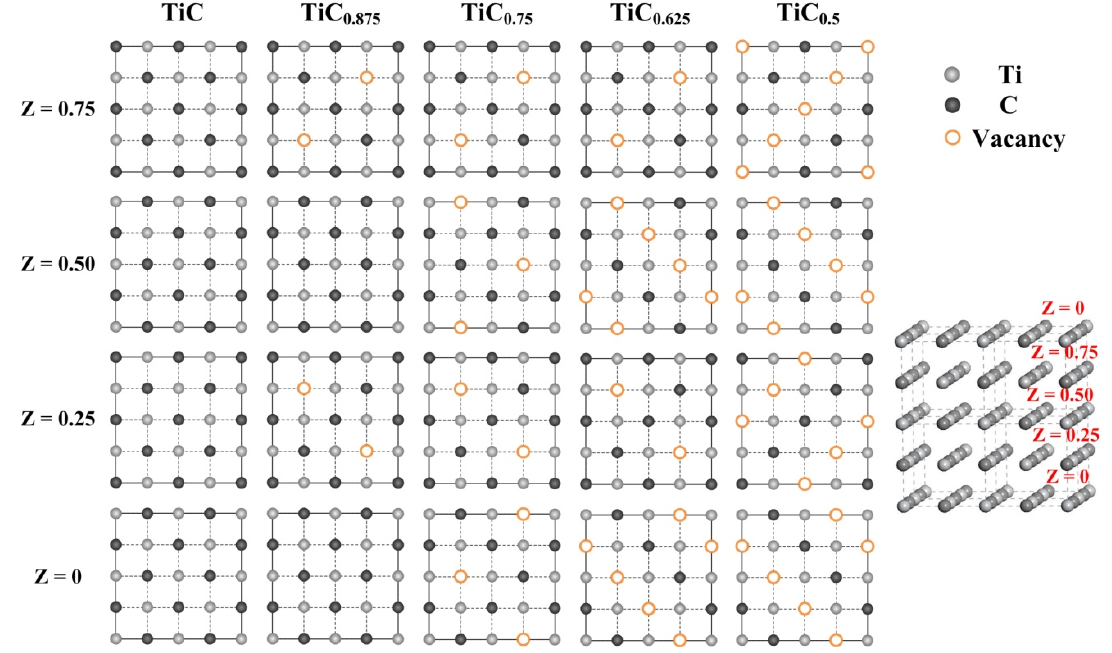
Figure 4. The structures schematic diagrams of TiC x phases with different stoichiometric ratio (as calculated by a 16-atom supercell). Z shows the different planes in the TiC x crystal, and the four planes from top to bottom are marked as 0, 0.25, 0.5 and 0.75, respectively.